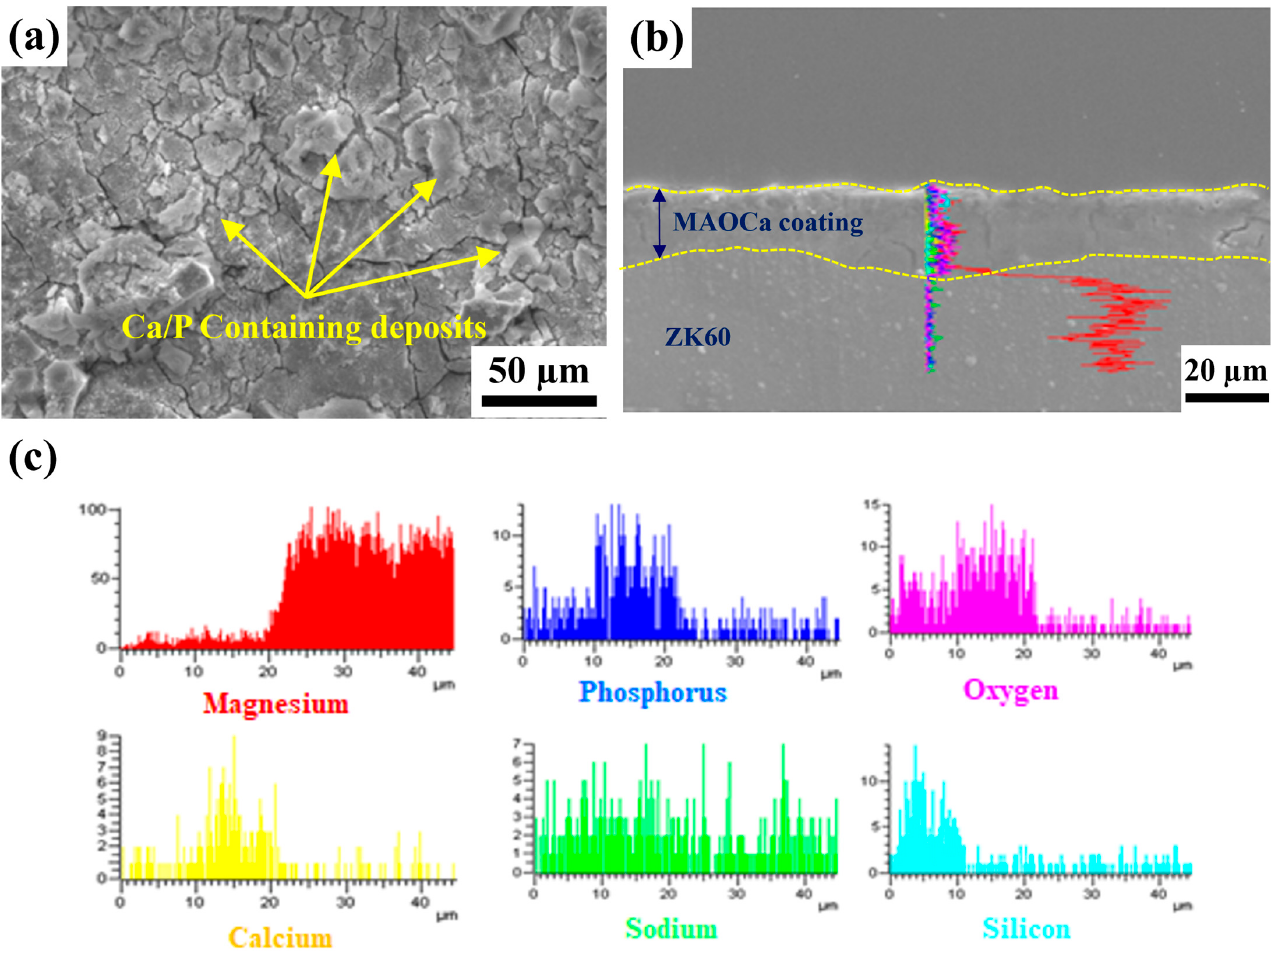
Figure 7. ( a ) SEM morphology and ( b , c ) EDS line scan analysis of the MAOCa-coated ZK60 samples.